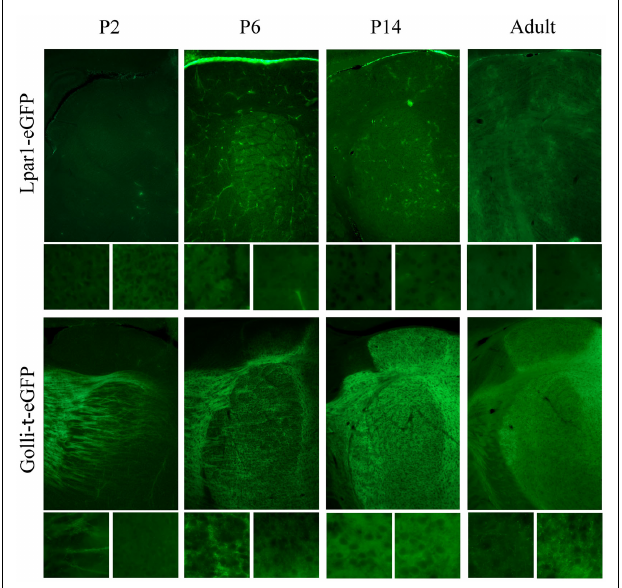
FIGURE 5 |The developing innervation of the thalamus by subpopulations of subplate neurons. Cortical sections, dorsal at top of image, lateral at left of image. Boxes beneath each image show higher magnification of theVB (left) and dLGN (right). Characterization of transgenic mouse lines Lpar1-eGFP and Golli-tau-eGFP identify clearly distinct, although overlapping, subpopulations of subplate neurons on coronal section of thalamus.These distinct populations innervate the thalamus with a different temporal pattern. At P2 Lpar1-eGFP fibers have not reached the RTN. By P6 GFP + fibers have enteredVB in a barreloid pattern. No fibers have entered the LGN. By P14VB and LGN have been innervated. In the Golli-tau-eGFP the GFP + fiber front is at the RTN and many fibers can be seen clearly enteringVB at P2. By P6 the fibers have fully enteredVB and are patterned in the septa between barreloids.The dLGN is not yet innervated however GFP + fibers accumulate betweenVB and the ventral edge of the dLGN. At P14 the Golli-tau fibers have innervatedVB in the hollows of barreloids.The dLGN is now completely innervated although the vLGN is not. dLGN, dorsal lateral geniculate nucleus; RTN, reticular thalamic nucleus;VB, ventrobasal nucleus; vLGN, ventral lateral geniculate nucleus.